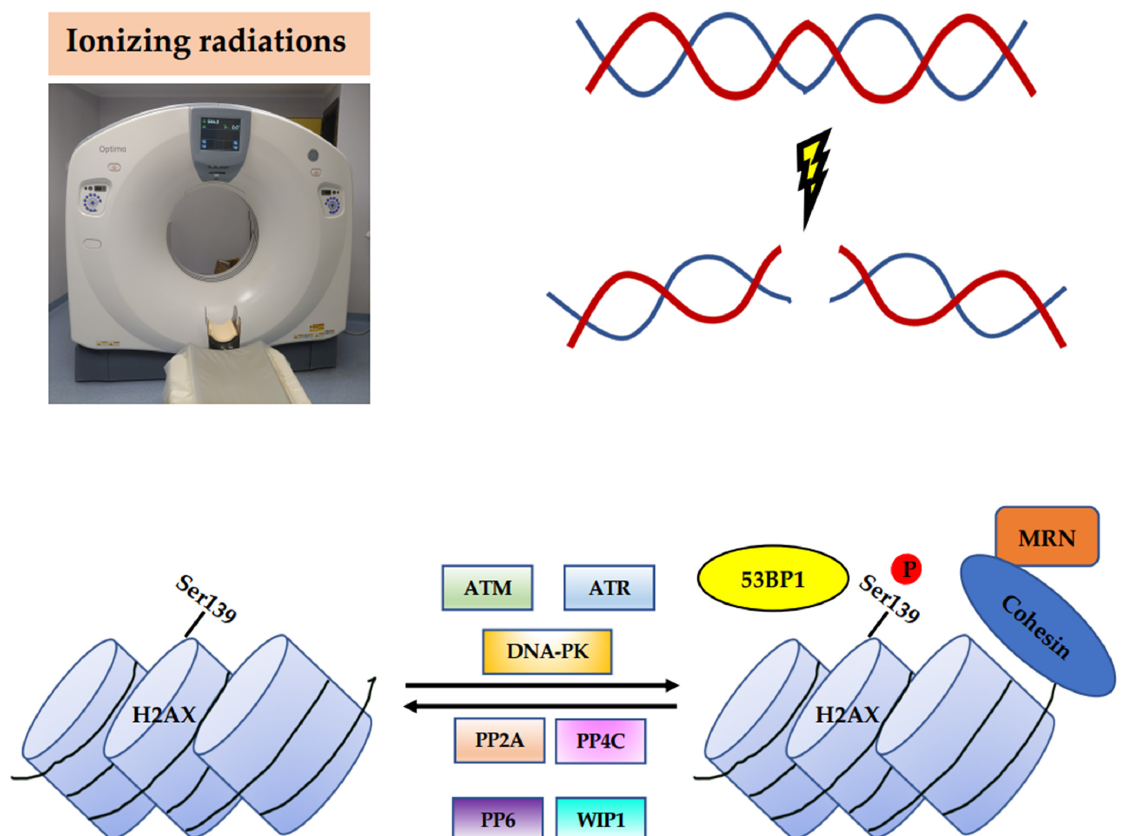
Figure 2. Phosphorylation of H2AX in the DSB response. Upon DSBs induced by IR, H2AX activity is regulated by Ser139 phosphorylation/dephosphorylation cycles. Phosphorylation is catalyzed by ATM, ATR, and DNA-PK. When H2AX is phosphorylated at the sites flanking DSBs, different repair proteins are recruited, including the MRN protein complex, 53BP1, and cohesins. After repair, γ H2AX is removed by dephosphorylation catalyzed by the protein phosphatases PP2A, PP4C, PP6, and